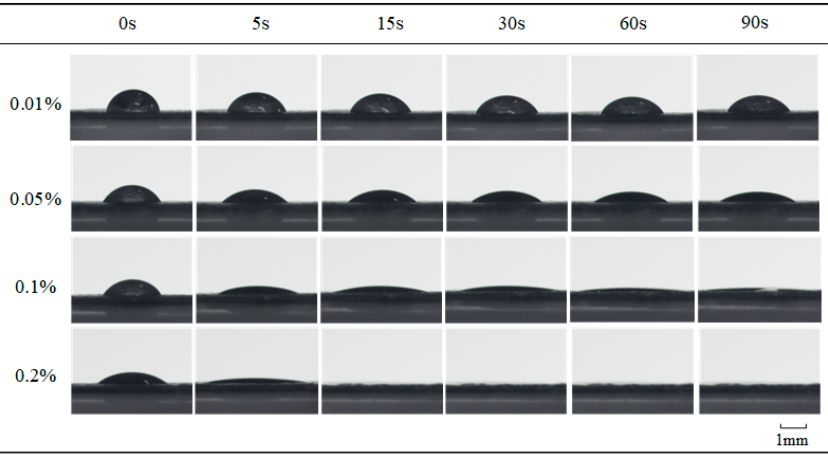
Figure 8. Deposition status of bifenthrin droplets with different concentrations of Silwet L-77 on the surface of young leaves over time.